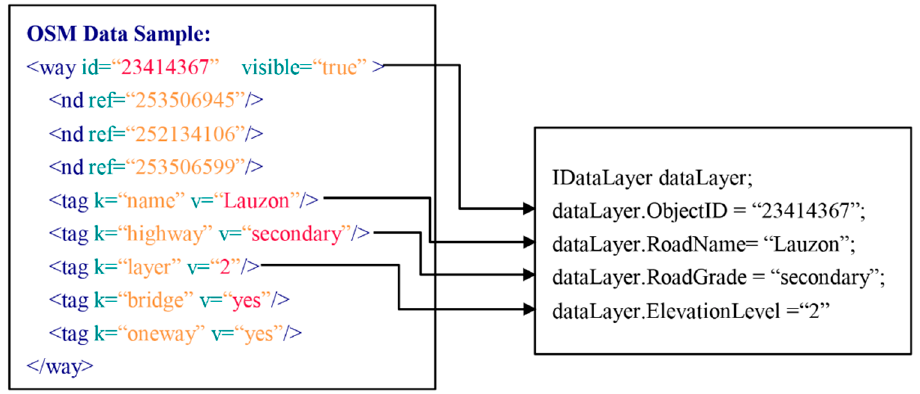
Figure 8. Open Street Map (OSM) data used to prepare a road network presentation.